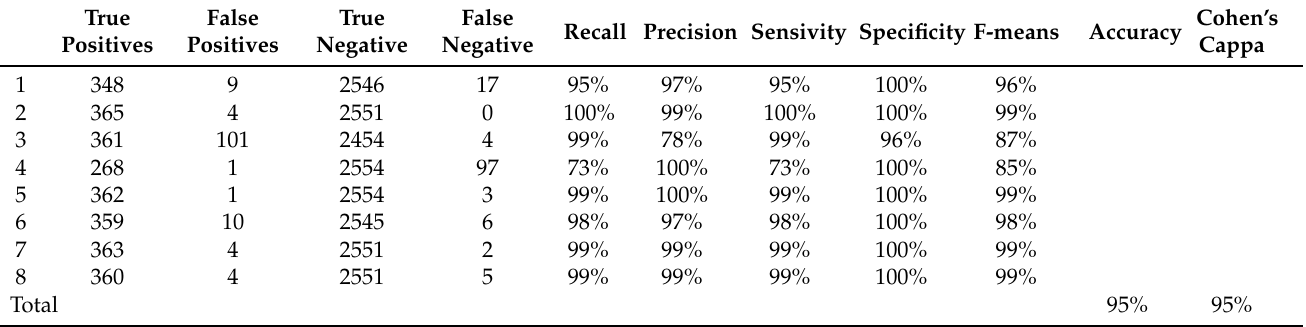
Table A4. The activity classification results for sensor s 4 ; and s 1 , s 2 , and s 3 as support